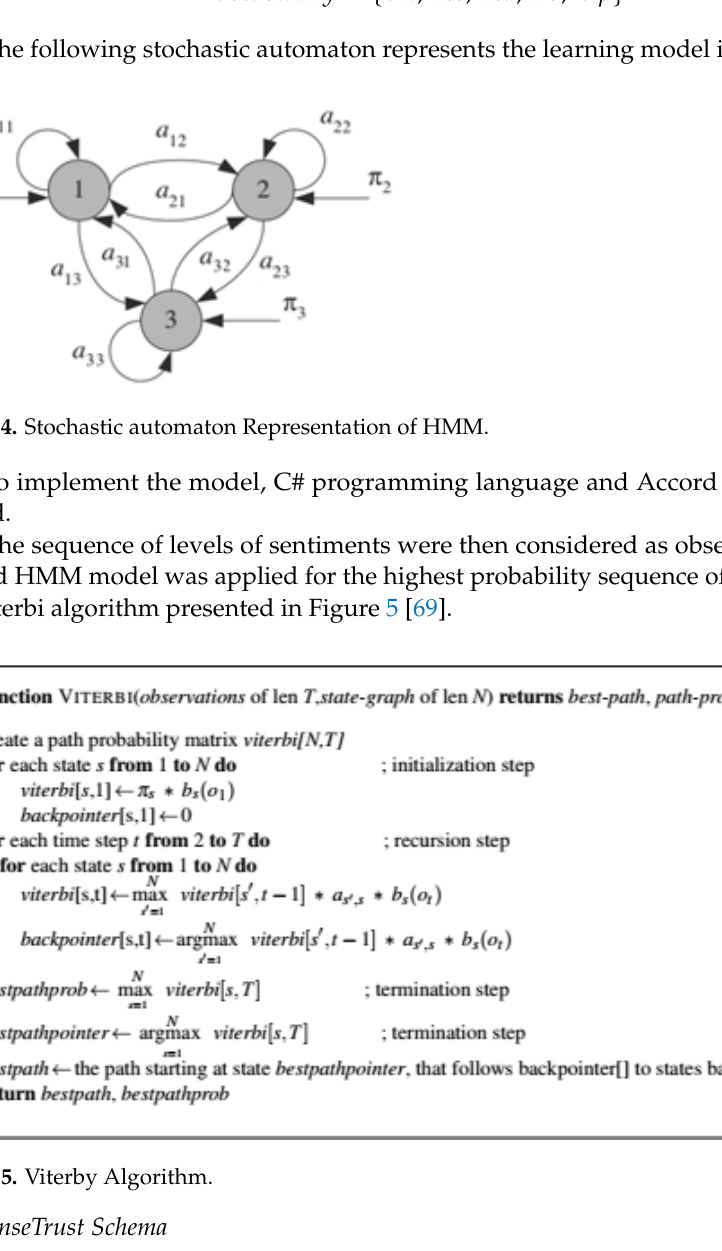
14 Figure 3. Example of RNTN ’ s Output After Training for Trust. For training HMM with the forward-backward algorithm, the following two compo- nents are required: A collection of HMM states: In the proposed model, states refer to the same levels of